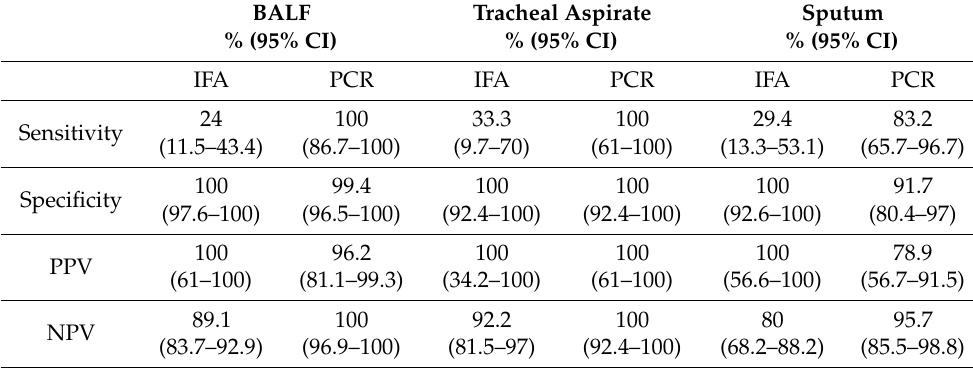
Table 3. Validation of PCR and IFA assays by type of respiratory sample.